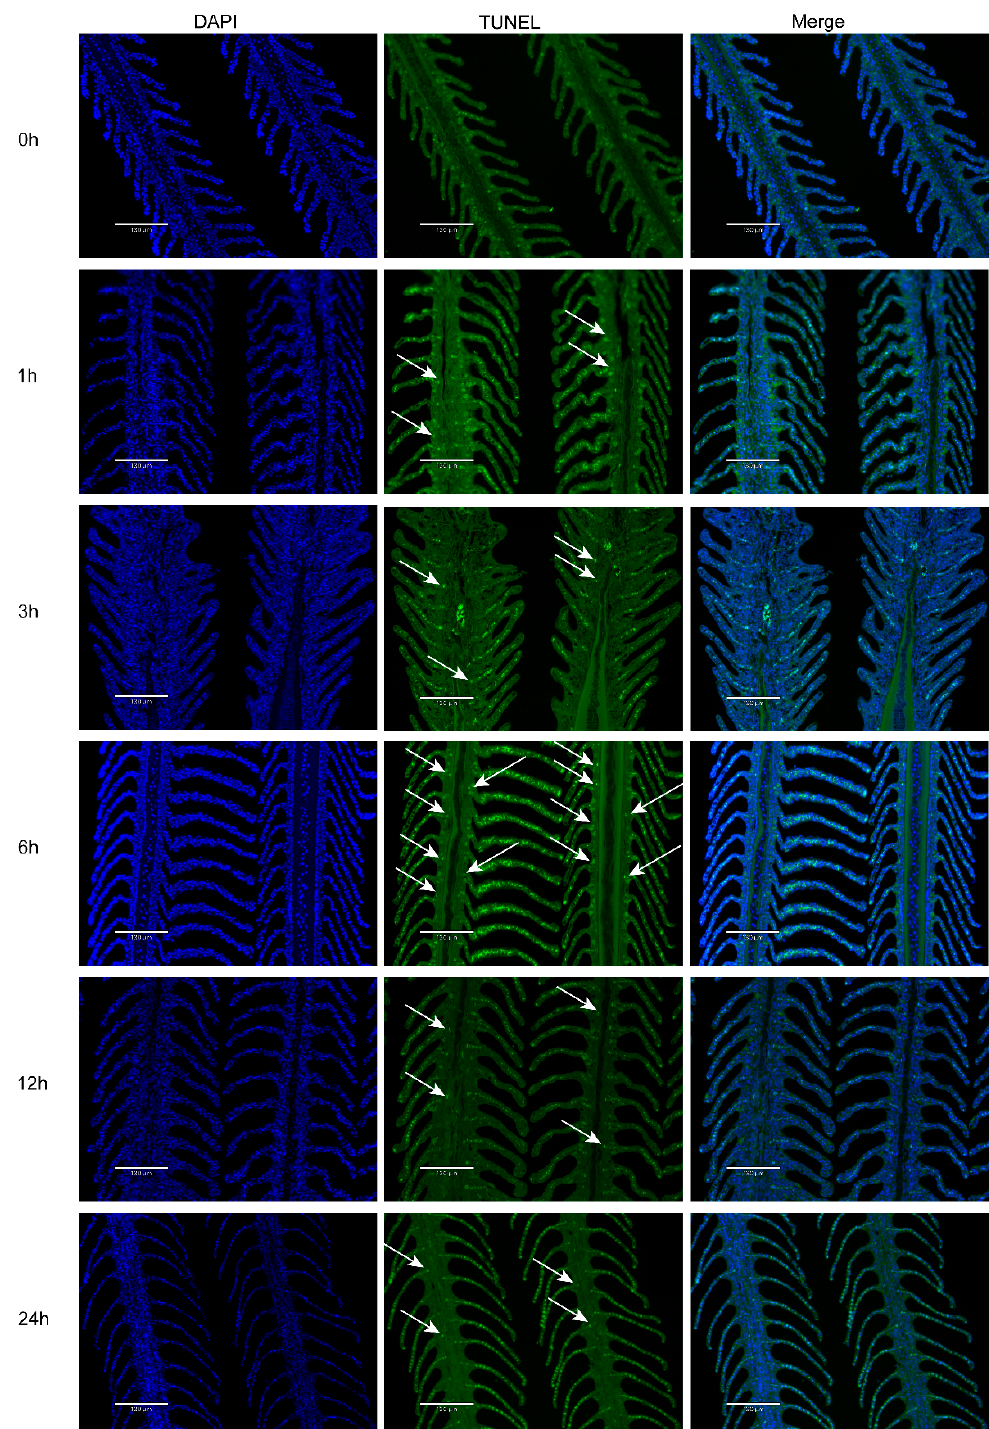
Figure 2. Apoptosis of gills under hypoxia. The gills of apoptosis showed green fluorescence and times on the left showed hypoxia stress times. The length of the scale bar represents 130 μ m. The arrows in the figure point to the location of the apoptosis signal.